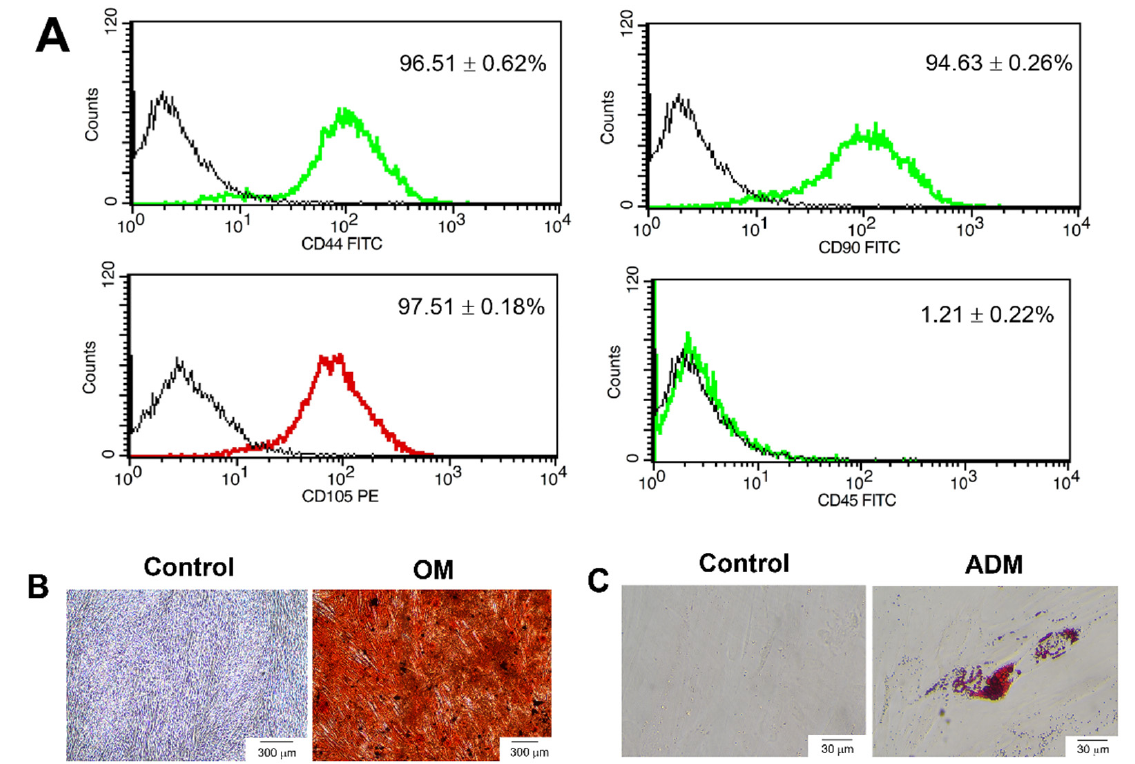
Figure 1 . Characterisation of human dental pulp stem cells (hDPSCs). ( A ) The surface marker ex- pression was analysed using flow cytometry. Multilineage differentiation potential to ( B ) osteogenic and ( C ) adipogenic lineage. Scale bars: 300 ( B ) and 30 ( C ) µm, respectively. The hDPSCs were cul- tured in an osteogenic differentiation medium (OM) and adipogenic differentiation medium (ADM). The mineral deposition was stained using Alizarin Red S (ARS) staining. The accumulation of lipid droplets in the cytoplasm was stained by Oil Red O staining.